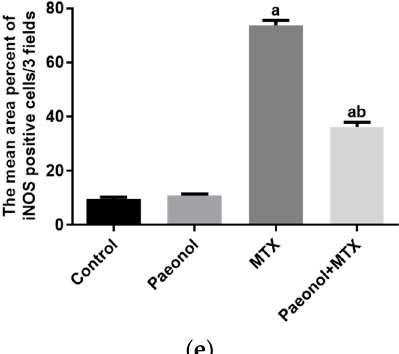
Figure 9. The immunohistochemical examination of hepatic inducible nitric oxide synthase (iNOS) expression in methotrexate (MTX)-induced hepatotoxicity (×400). The liver tissues of the control ( a ) and paeonol ( b ) groups show hepatocytes with faint cytoplasmic iNOS expression (yellow arrows). The liver tissues of the MTX-treated rats show hepatocytes with intense cytoplasmic iNOS expression (yellow arrow) ( c1 ). Expression is also noticed in the portal area (square) ( c2 ). In contrast, the liver tissues of the paeonol + MTX group show hepatocytes with little iNOS expression (yellow arrow) ( d1 ). Little expression is also noticed in the portal area (square) ( d2 ). A semi-quantitative analysis of iNOS positive cells ( e ). Data are represented as mean ± SEM ( n = 6). Letters a,b Denote significant differences from the normal control and the MTX groups, respectively, at p < 0.05.